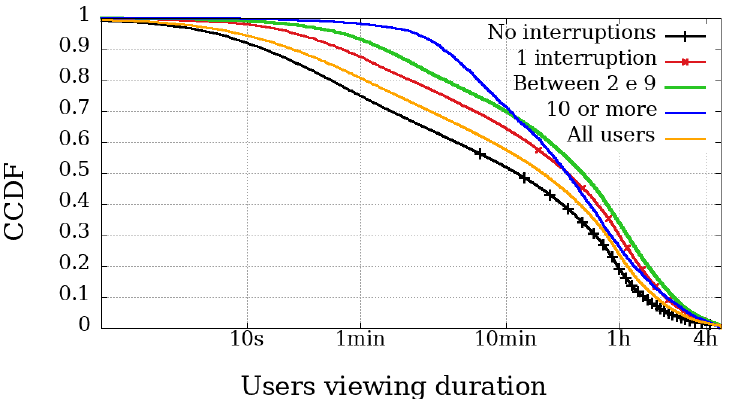
Figure 8. Complementary cumulative distribution function of the viewing duration from users, grouped by the amount of interruptions experienced in the transmission session of the Opening Rio 2016 Olympic Games—mobile devices.